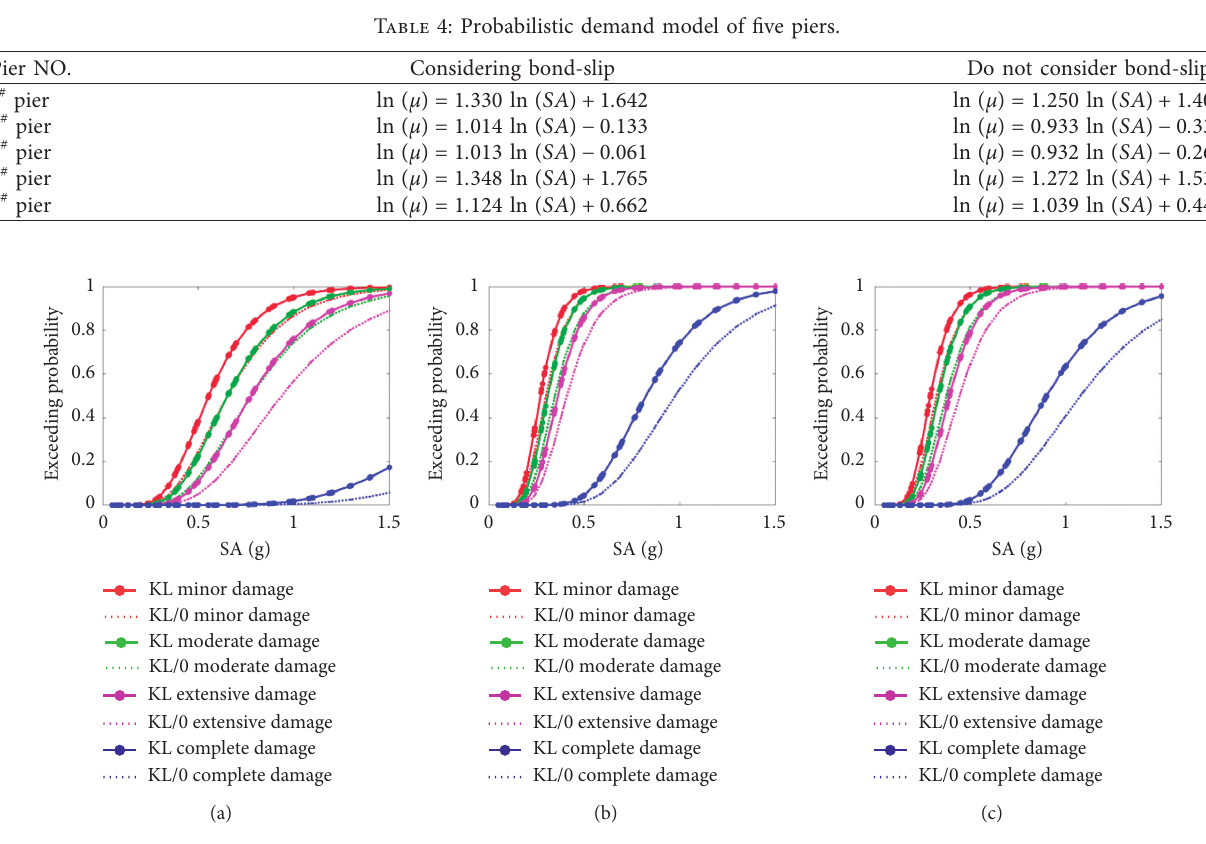
Figure 6: Fragility curves of piers. (a) 1 # pier. (b) 2 # pier. (c) 5 # pier.